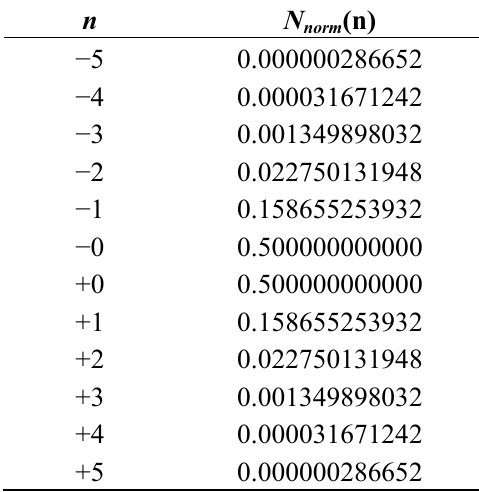
Table 2. Fractional number of outliers deviating from the mean by more than n standard deviations for the normal statistical distribution, N